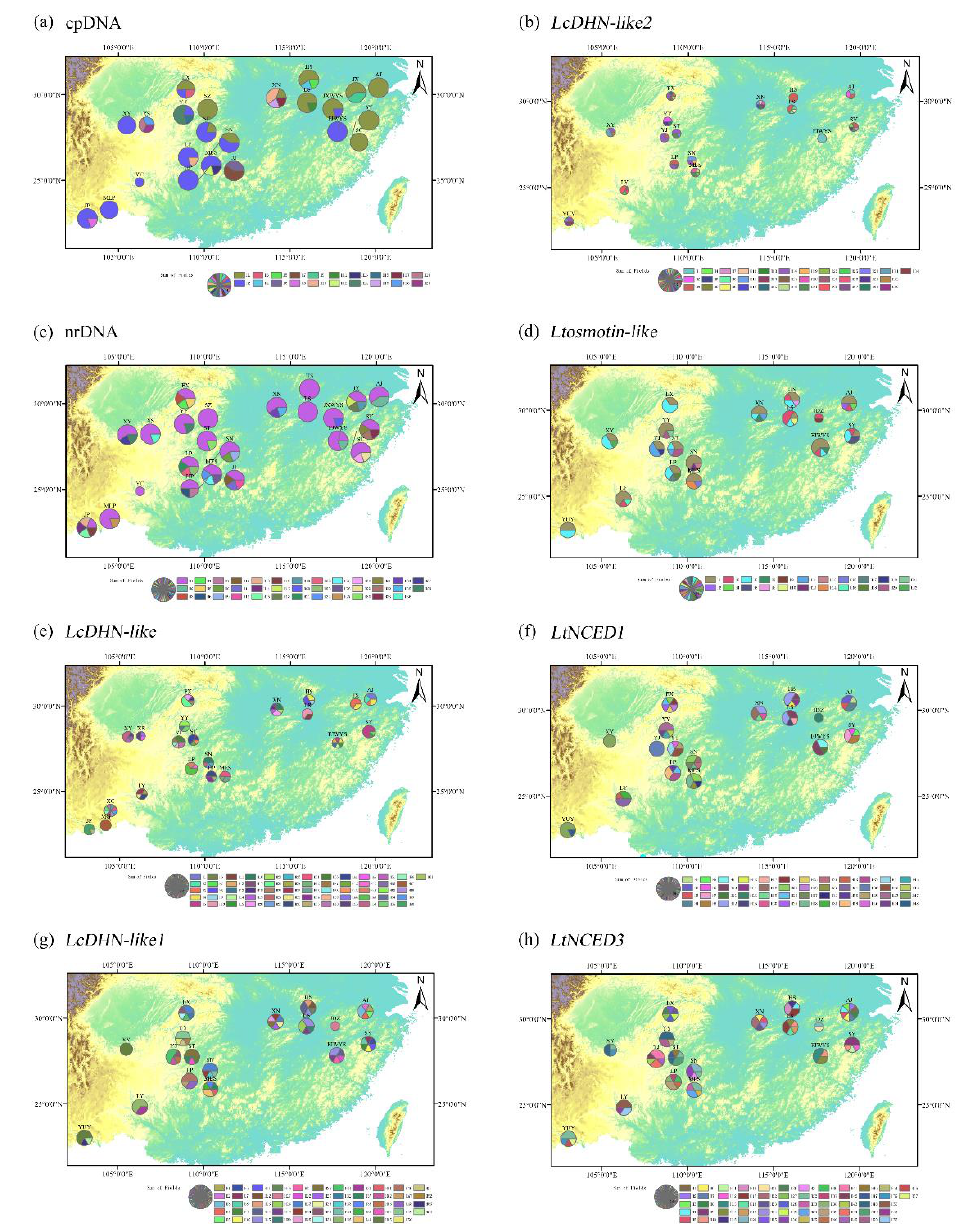
Figure 5. Geographic distribution of haplotypes of cpDNA, nrDNA, and six nuclear genes ( LcDHN-like , LcDHN-like1 , LcDHN-like2 , LtNCED1 , LtNCED3 , and Ltosmotin-like ) in L. chinense ( a – h ). Pie chart size is proportional to its numbers. The map was created by ArcGIS 10.2.